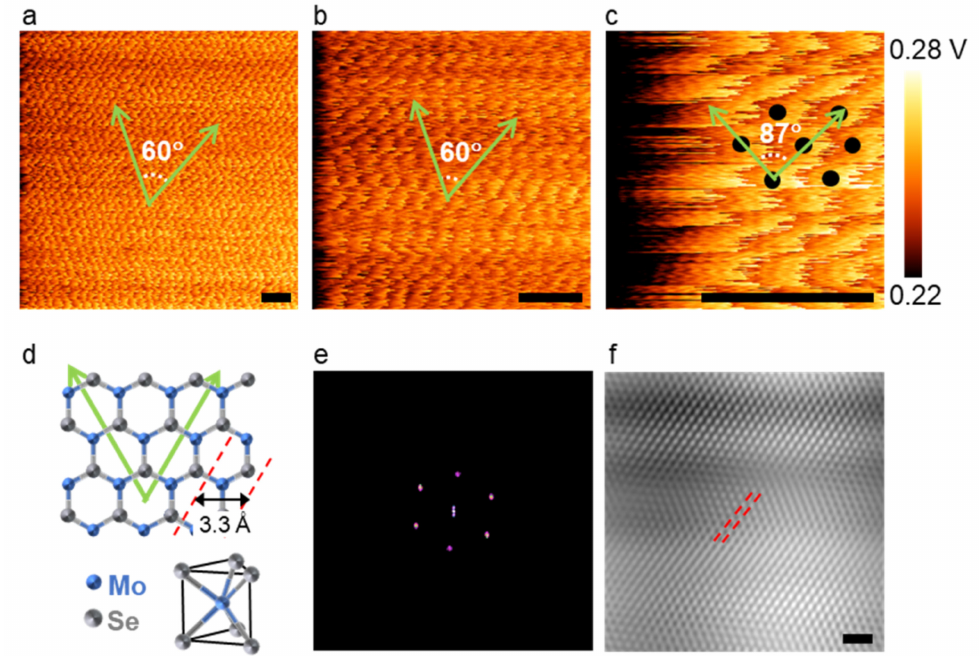
Figure 2. Scan size-dependent atomic lattice images (only color range adjusted). ( a – c ) LFM raw im- ages of a MoSe 2 monolayer acquired with nominal lateral scan sizes of 160, 70, and 25 Å, respectively (calibrated scale bar: 1 nm; scan rate: 19 Hz). All green arrows are aligned along the zigzag direction as illustrated in ( d ). The black dots in ( c ) are for visual guidance and represent the centers of the hexagonal rings in MoSe 2 (i.e., the hollow sites); ( d ) schematic model of MoSe 2 . Mo and Se atoms are marked with blue and grey spheres, respectively; ( e ) filtered FFT image of the LFM raw image shown in ( a ); ( f ) inverse FFT image (scale bar: 1